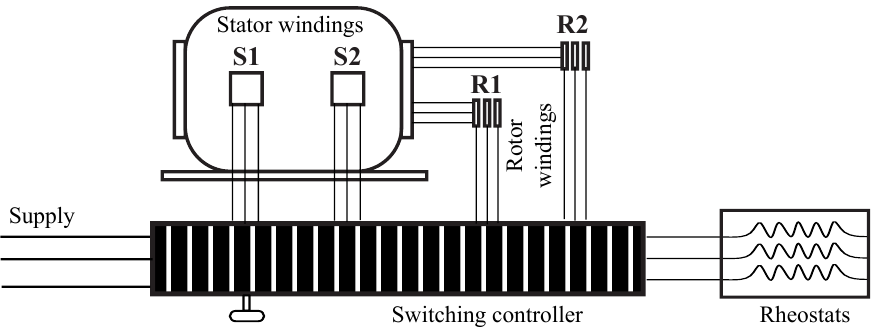
Figure 3. Schematic representation of the Lydall motor [13].